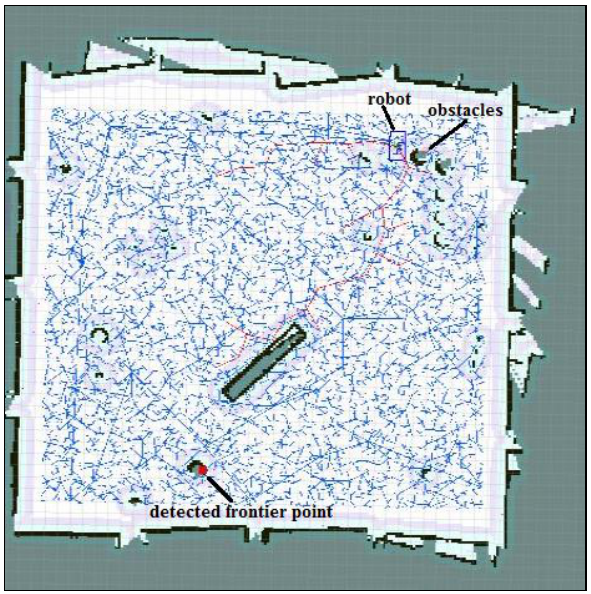
Figure 12. Performance of RRT on simulated